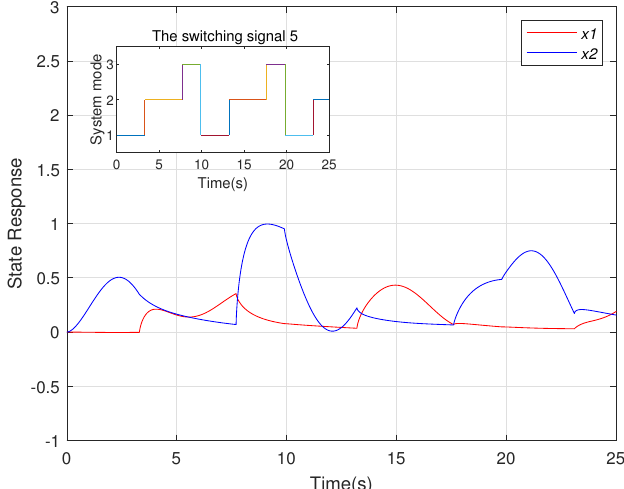
Figure 5. The stateresponse of the system under the signal